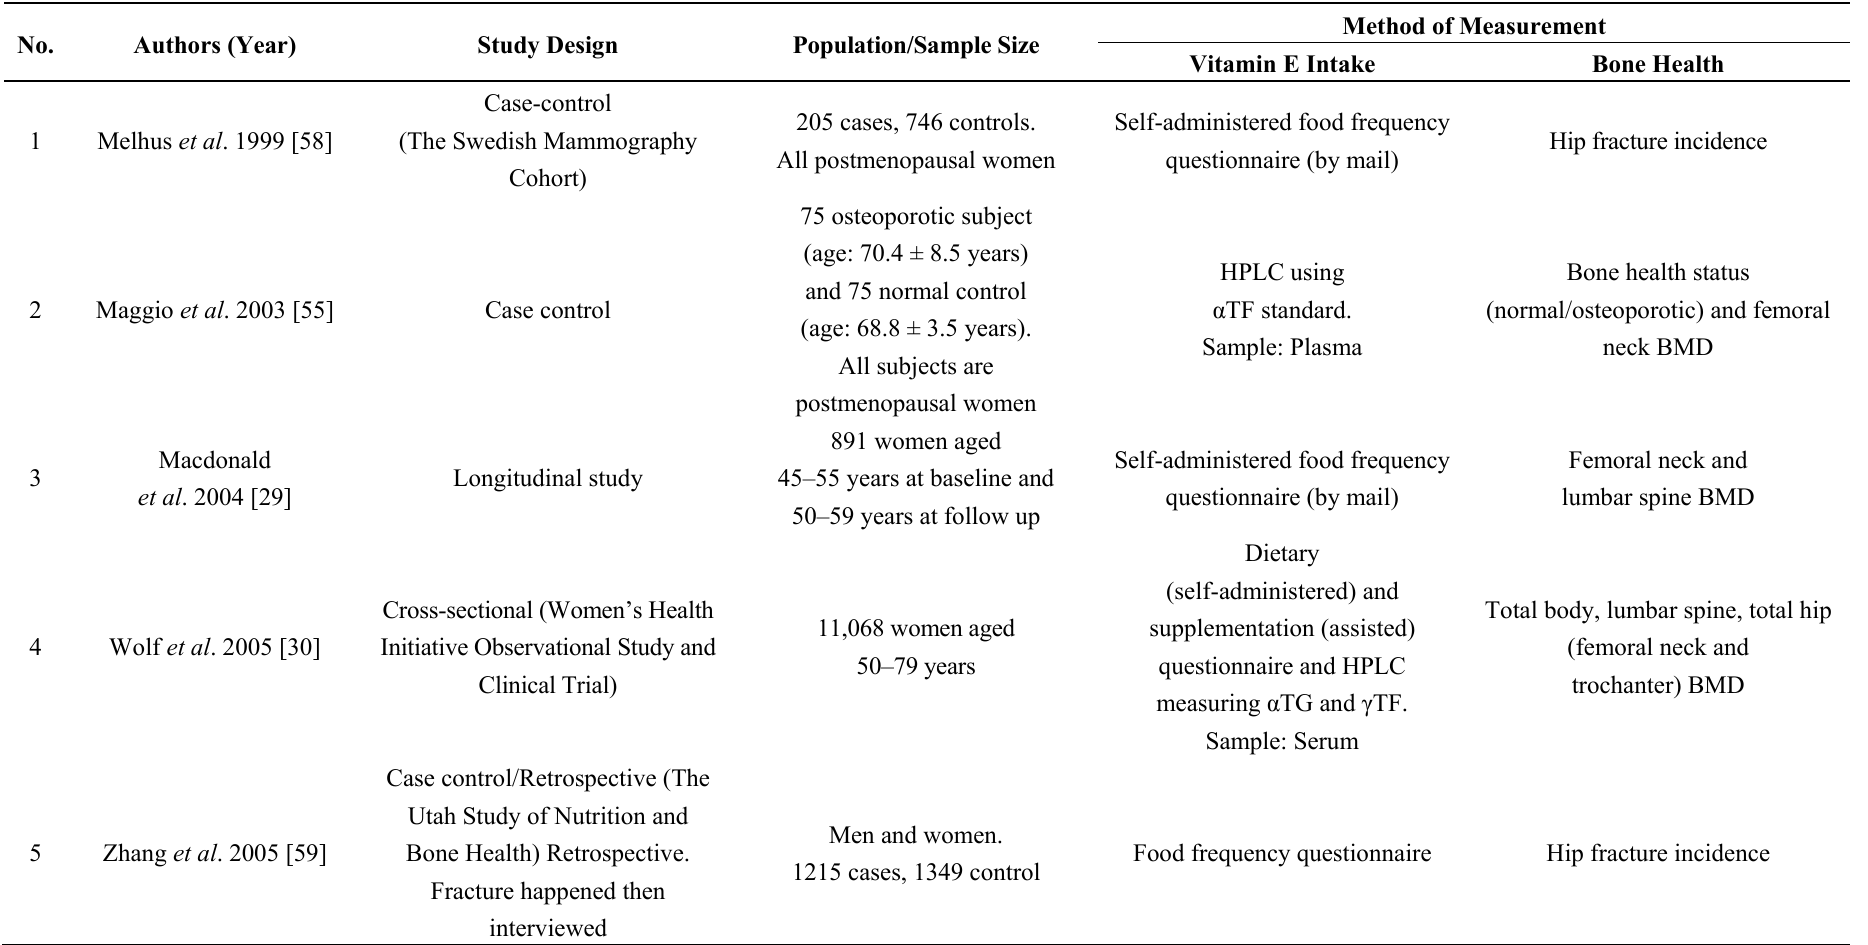
Table 1. The study designs of the human studies assessing the relationship between α -tocopherol and bone